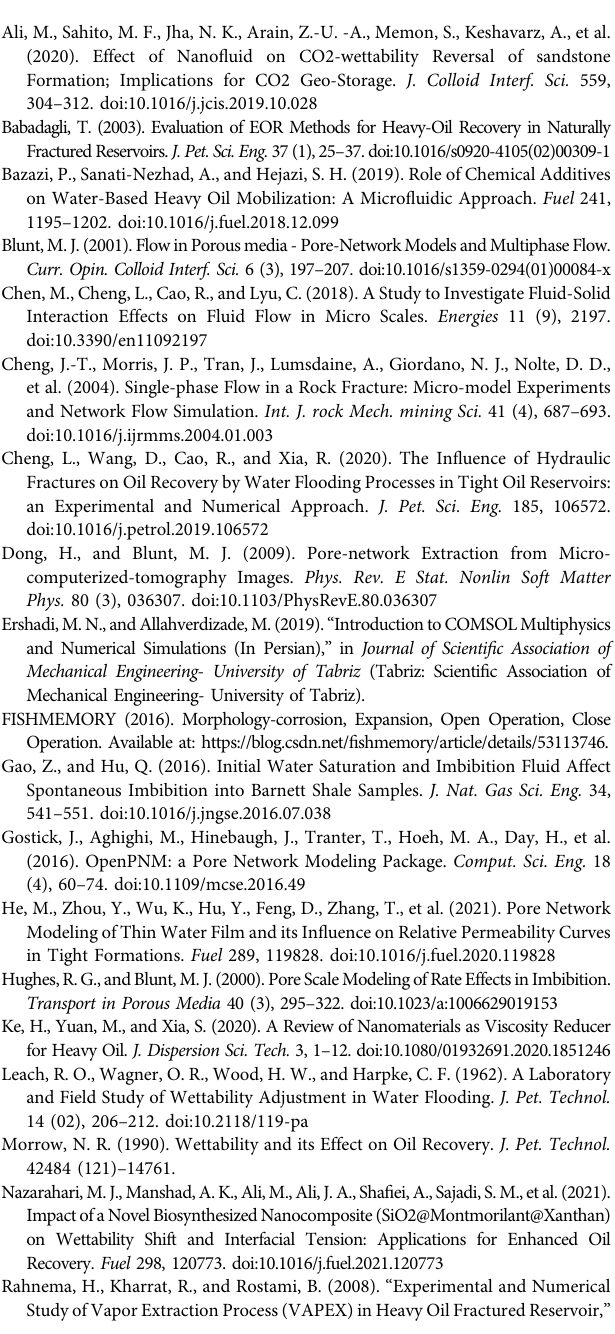
Supplementary Figure 1 | Comparison of relative permeability under different wettability conditions.